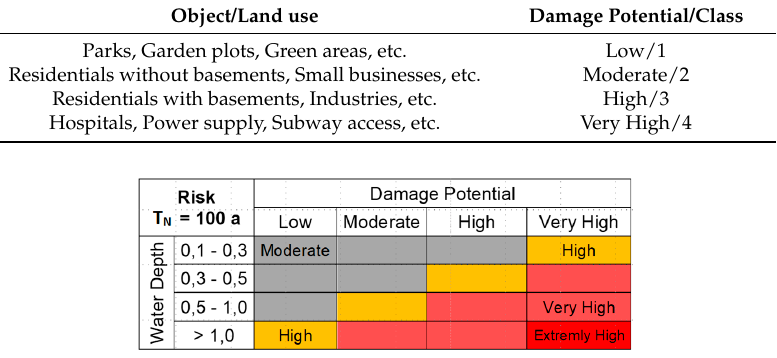
Figure 3. Risk matrix used for scenario 3 ( T N = 100 a) modified after DWA-M 119 [46].